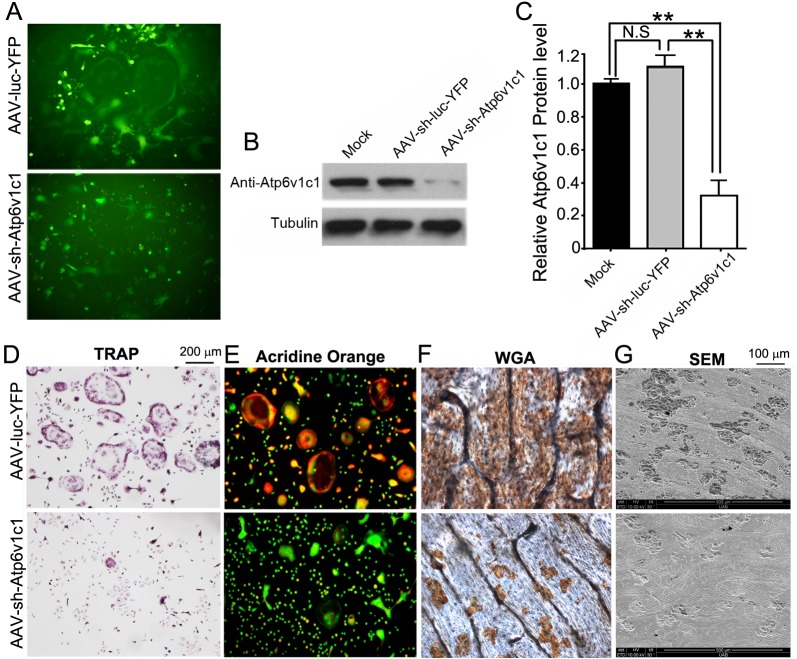
The expression of Atpv1c1 was efficiently knocked down by AAV-sh-Atp6v1c1.(A-G) M-CSF/RANKL was applied for 3 days to allow differentiation of osteoclasts, which were then transduced with AAV-sh-Atp6v1c1, AAV-sh-luc-YFP, or untreated (mock). (A) Transduction of osteoclasts was successful indicated by fluorescence. (B, C) Atpv1c1 protein level by Western blot showed that AAV-sh-Atp6v1c1 treated osteoclasts have reduced Atp6v1c1 expression significantly (P<0.01). (D) TRAP staining revealed that the number of osteoclasts was decreased in the AAV-sh-Atp6v1c1 treatment group. (E) AAV-sh-luc-YFP (control) or AAV-sh-Atp6v1c1 transduced osteoclasts were stained with acridine orange to show extracellular acidification. (F) Wheat germ agglutinin (WGA) was applied for visualizing resorption lacunae and (G) scanning electron microscopy (SEM) showed that osteoclast-mediated bone resorption was inhibited by ATP6v1c1 knockdown. **: P<0.01, N.S: No Significance.